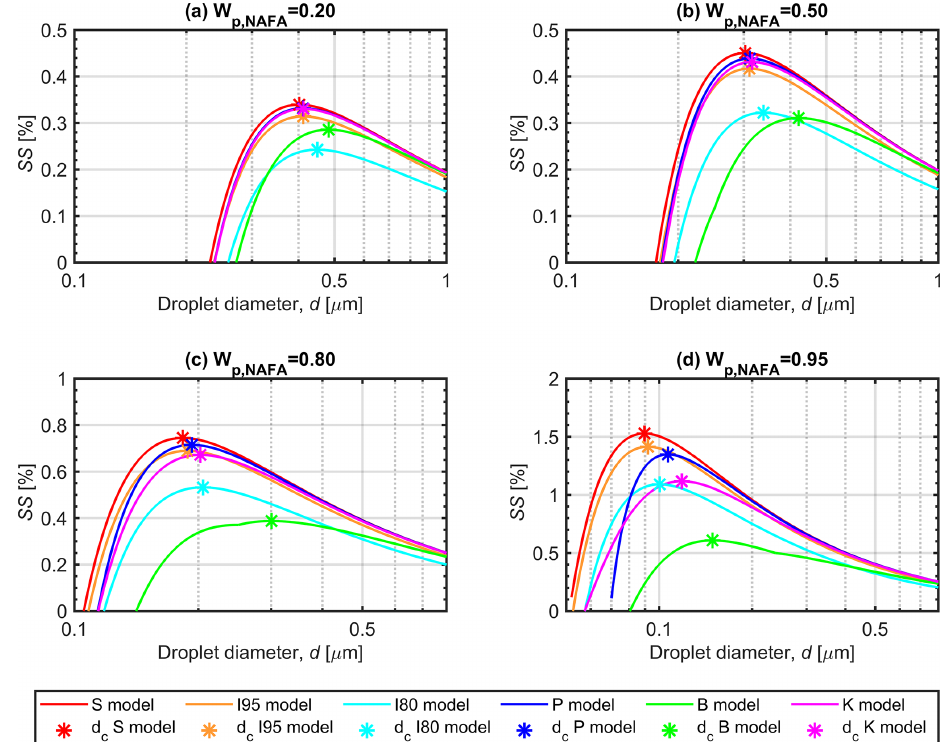
Figure 3. Köhler curves for growing aqueous NAFA–NaCl droplets formed from 50nm dry particles with NAFA mass fractions of (a) 0.20, (b) 0.50, (c) 0.80, and (d) 0.95, calculated with the different models described in Sect. 2.4. The critical points of droplet activation (SS c ) presented in Figs. 1 and S1 are indicated with asterisks on each Köhler curve. Note that the supersaturation (SS) scale is different between the